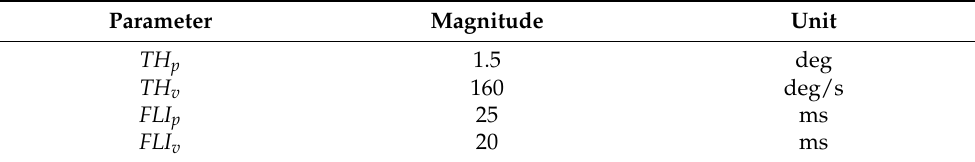
Figure 19. Stability constraint map for OLM functions for fault ID = 18, 23 and 25. Table 11. Optimum OLM/ILM parameters at sampling rate of 1 kHz.